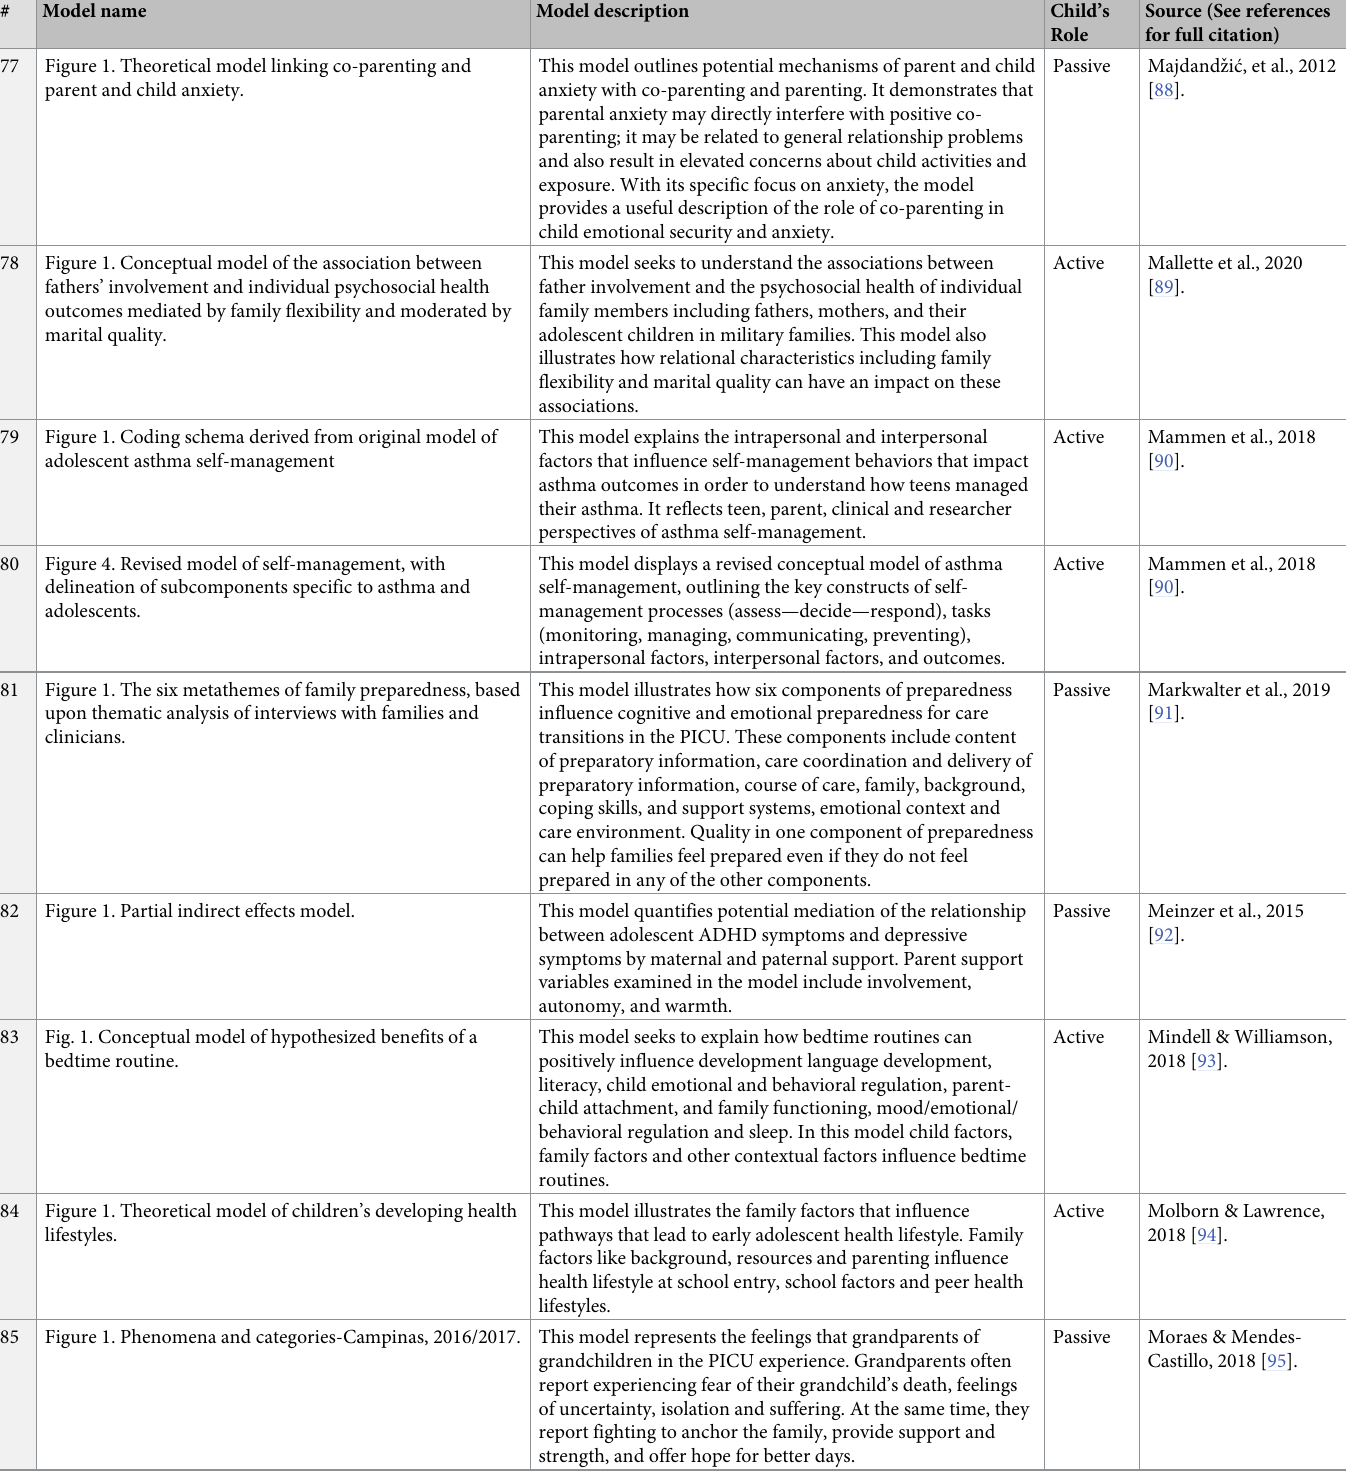
Figure 1. Theoretical model linking co-parenting and parent and child anxiety.